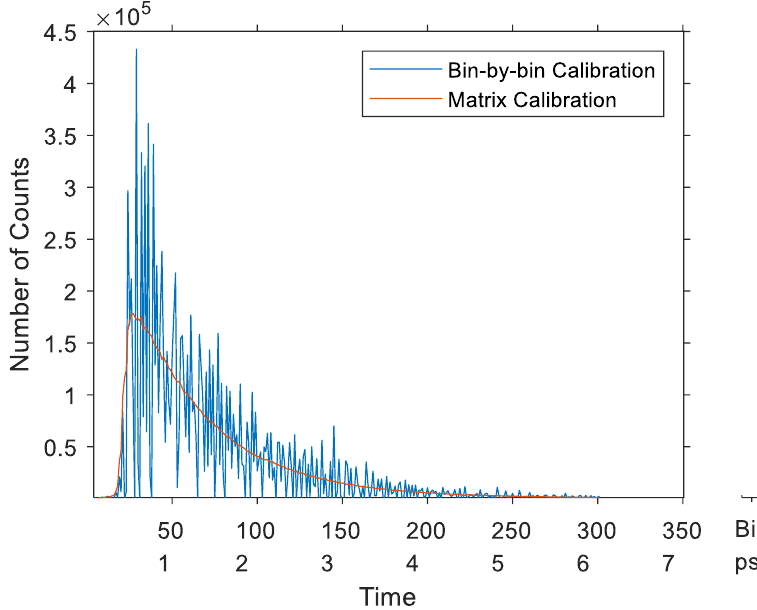
Figure 18. Fluorescence signal of a piece of paper using the two calibration methods — synchronous TDC.